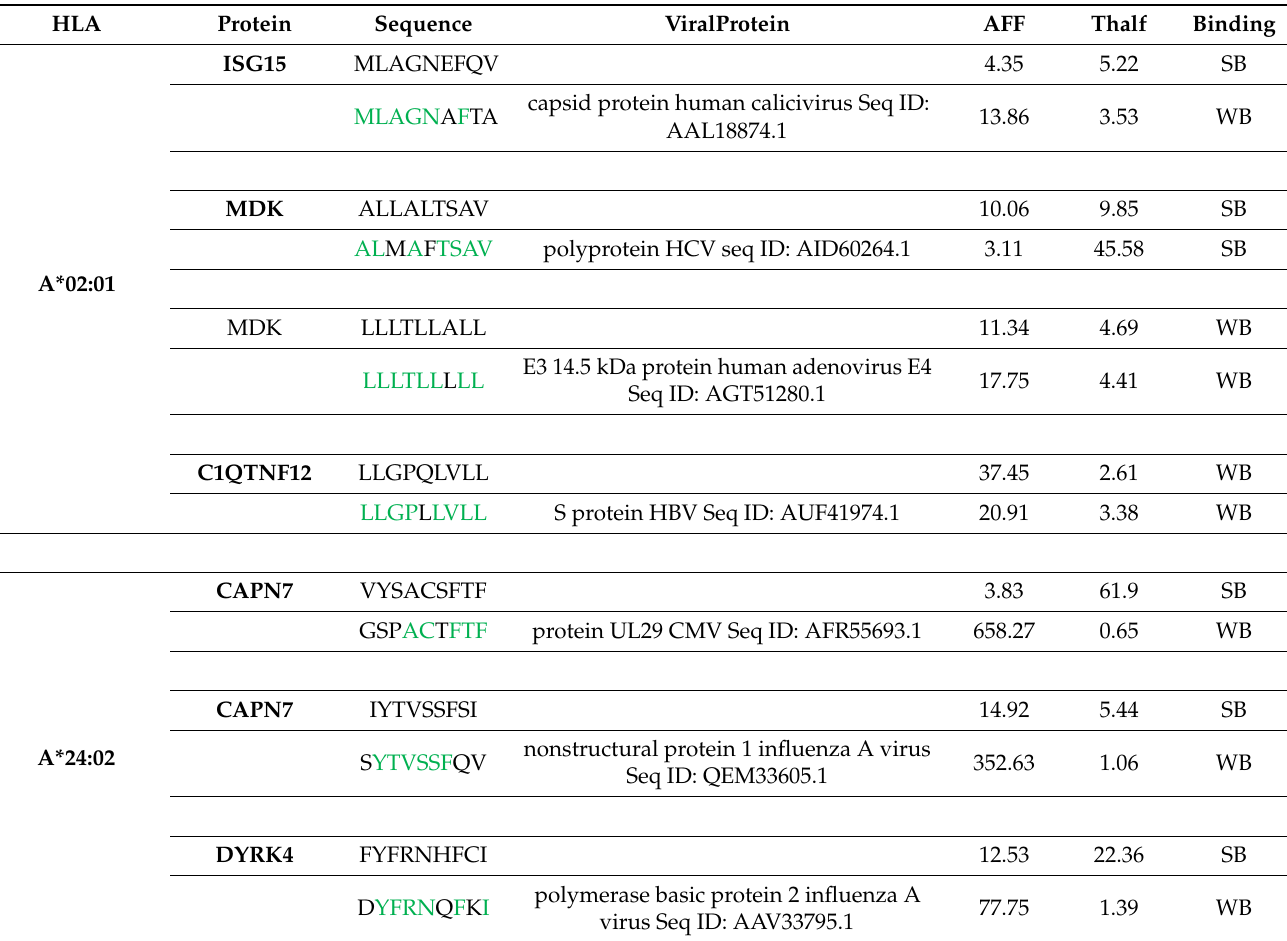
Table 2. List of TAA and viral-derived paired epitopes predicted as strong/weak bind level (SB/WB) by both NetMHCpan4.1 and NetMHCstabpan1.0